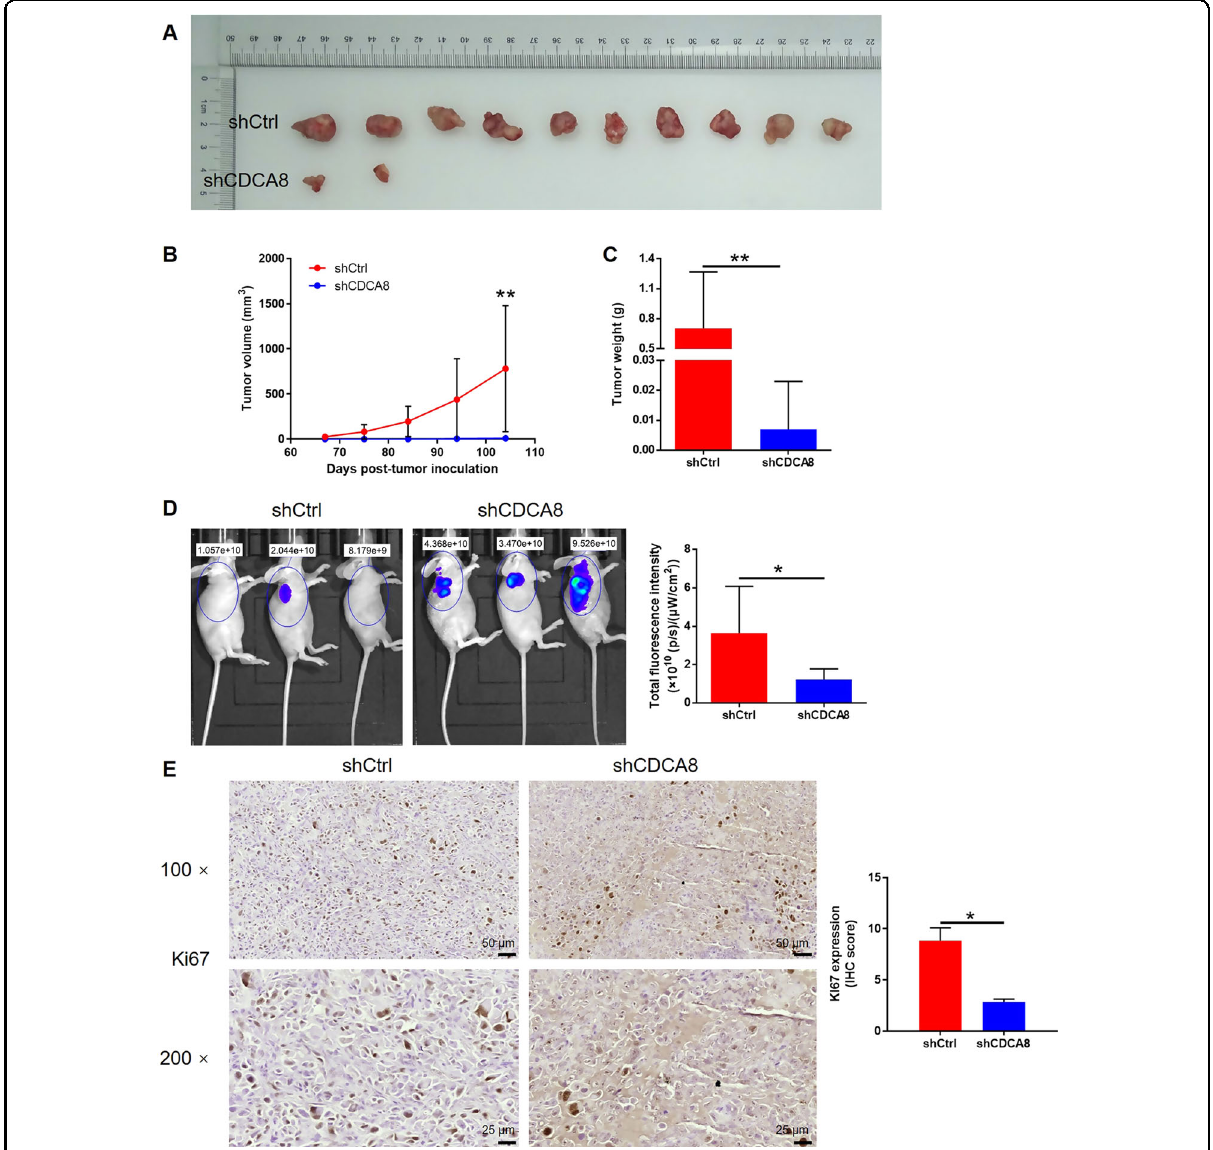
Fig. 3 Knockdown of CDCA8 inhibited tumorigenesis and glioma growth in vivo. Mice xenograft models were constructed by subcutaneously injecting U251 cells. A Dissected tumors from xenograft models with or without shCDCA8 after implantation were collected for taking photos. B Tumor growth curve for tumor volume calculation (from 67 to 104 days post injection). C Tumor weight of mice xenograft model analysis was measured after tumor collection. D In vivo fl uorescence imaging of tumor burden was performed just before sacri fi cing the mice. E Ki67 level by IHC analysis in tumor sections was detected after the tumor collection. Data were performed by mean with SD. * P < 0.05, ** P <